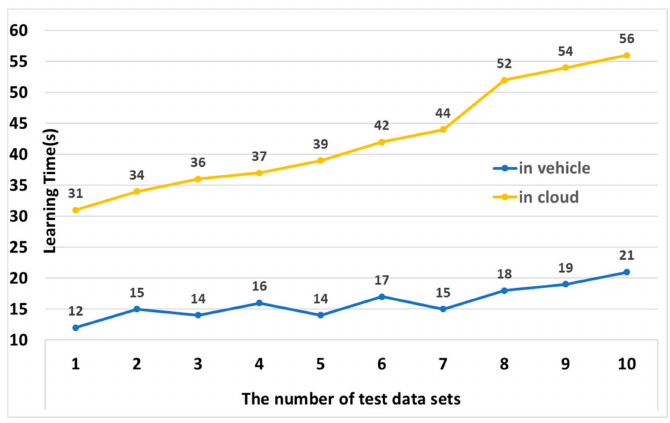
Figure 10. Performance analysis of HMM learning.